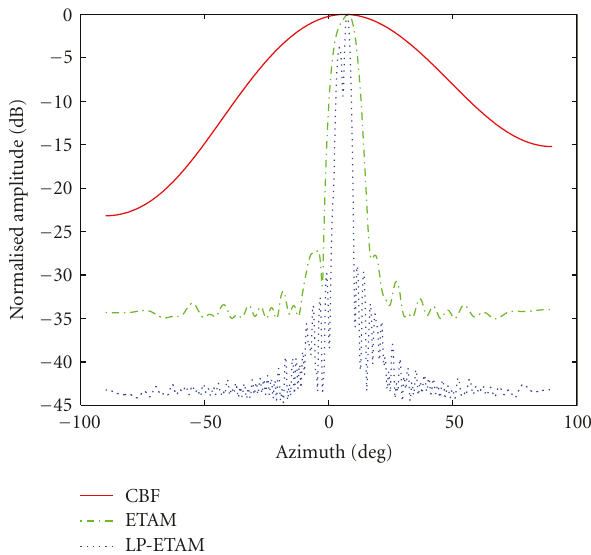
Figure 10: The comparison of spatial spectrums of the three methods (lake test